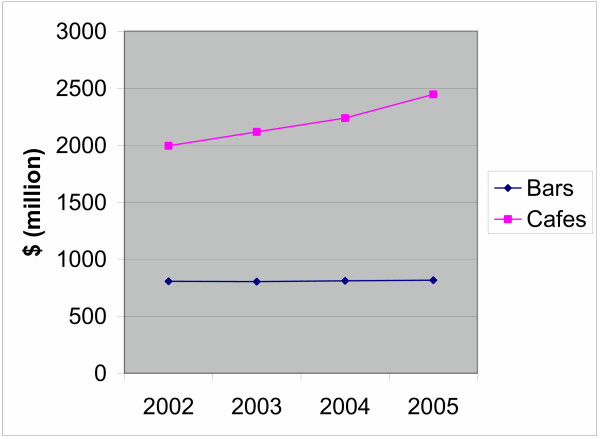
National sales volumes for bars and clubs compared to cafés and restaurants: January-September for 2002–2005. National data from Statistics New Zealand [32].